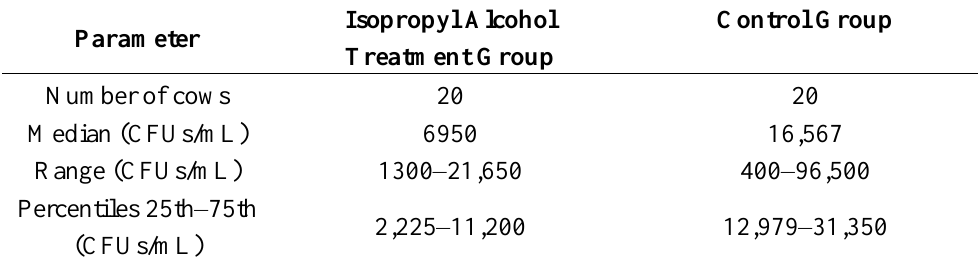
Table 1. Bacteriological culture results for the isopropyl alcohol treatment group and the control group of gluteal skin injection